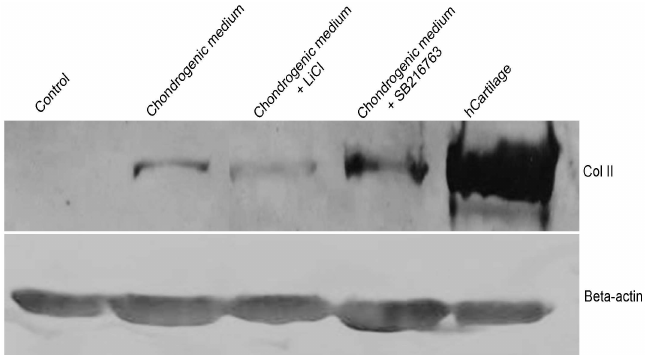
Fig 6. The collagen type II protein after 4 weeks of inductions examined by western blot analysis. β - actin was used as an internalcontrol.